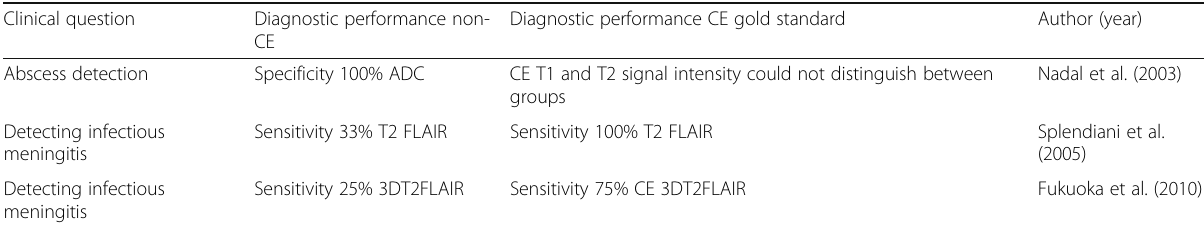
Table 4 Diagnostic accuracy measures in non-contrast-enhanced MRI techniques and contrast-enhanced techniques in brain infection Clinical